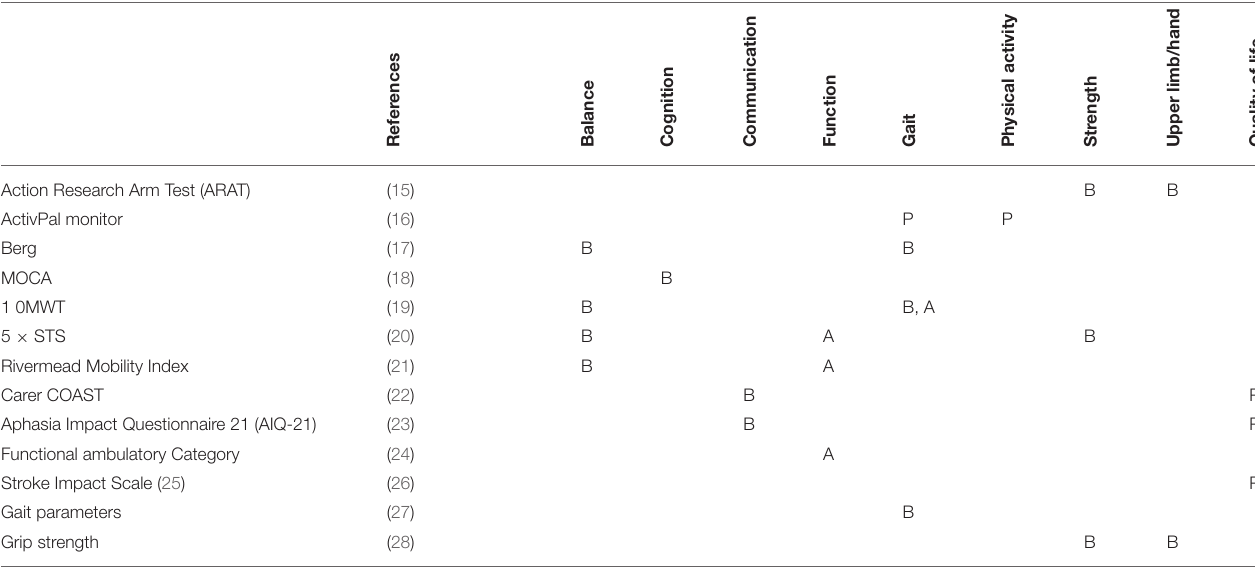
TABLE 3 | Outcome measures used in pilot matched to the ICF